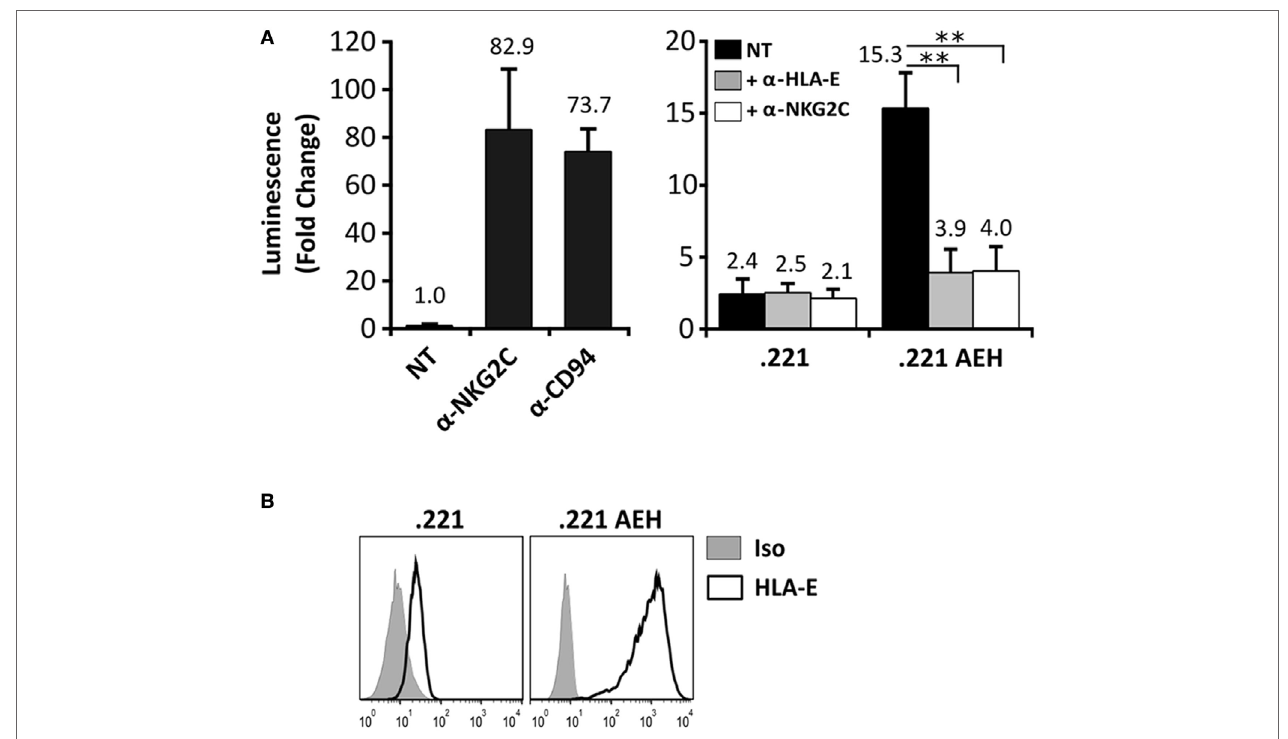
FigUre 2 | Specific engagement of the CD94/NKG2C receptor by HLA-E activates the Jurkat-NKG2C + reporter. (a) Jurkat-NKG2C + cells were electroporated with 3 × NFAT/AP1-Luc plasmid, followed by stimulation with: (a) anti-NKG2C or anti-CD94 monoclonal antibodies (mAbs) pre-adsorbed to culture plates or (b) with .221 or .221-AEH cells. After 18–24 h, cells were collected, lysed, and Luc activity was measured. Blocking experiments were carried out pretreating .221 and .221-AEH cells with anti-HLA-E 3D12 mAb (gray bars) or Jurkat-NKG2C + cells with anti-NKG2C mAb (white bars); NT, not treated. Data correspond to three independent experiments (mean ± SD). (B) HLA-E expression by .221 and .221-AEH was assessed prior to coculture with Jurkat-NKG2C + cells (gray histograms represent the isotype control). Statistically significant differences are indicated (** p <